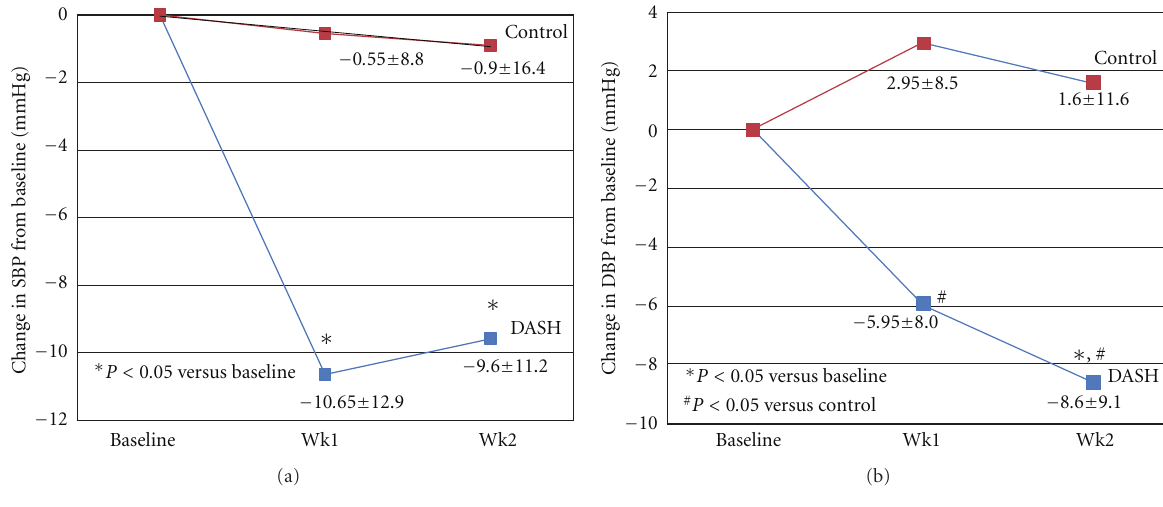
Figure 2: Blood pressure changes from baseline by